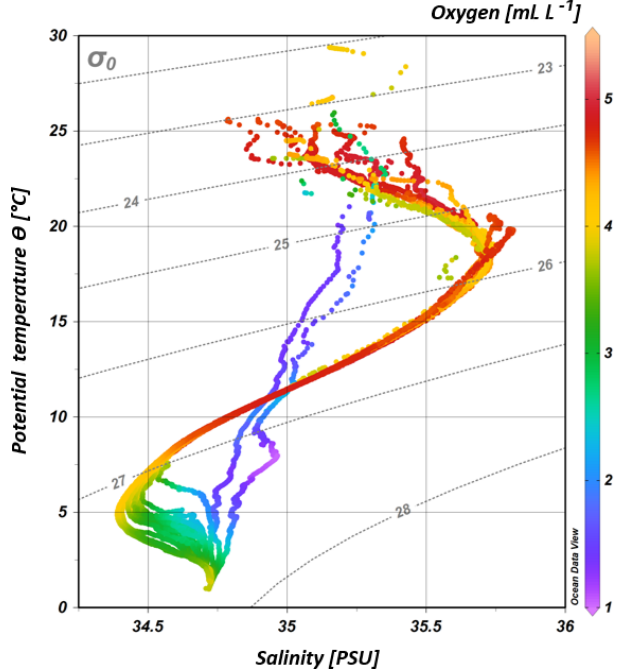
Figure 3. T–S (potential temperature vs. salinity) diagram from CTD measurements during the MSM 59/2 (2016) and SO 259 (2017) cruises. The colour bar indicates oxygen concentra- tions, and the grey, dotted lines represent density surfaces in sigma- theta (kgm − 3 ). The northernmost CTD stations (CTD 01, CTD 03; 2017) are characterized by low oxygen concentrations (<2mLL − 1 ) and less variation in the salinity distribution, whereas the water col- umn profiles in the IOSG indicate a distinct salinity maximum and minimum, respectively.